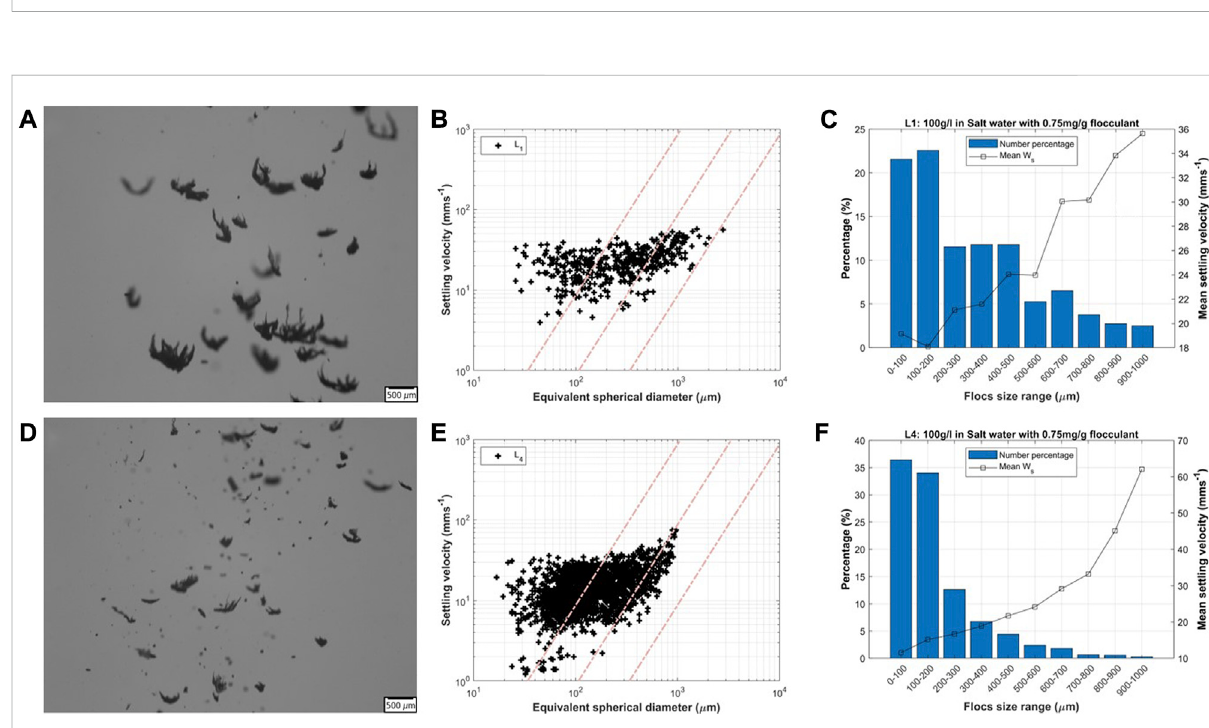
FIGURE 9 Figures (A,D) snapshots of the videos; Figures (B,E) : Settling velocity and particle size analysis of the samples collected at location L1 and L4 during lock exchange experiments with 100 g L − 1 illite and 0.75 mg g − 1 of fl occulant in saltwater. Settling velocity is derived as a function of equivalent spherical diameter, with diagonal dashed lines representing the contours of effective density calculated by using Stokes equation (from left to right: 1600, 160, 16 (kgm − 3 )). Figures (C,F) show fl oc size range and mean settling